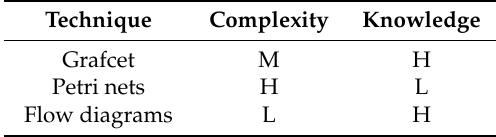
Table 5. Selection of the control algorithm technique.